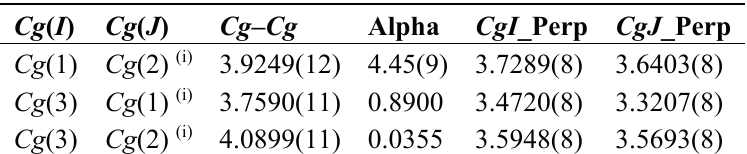
Table 2. π - π interactions (Å, °).